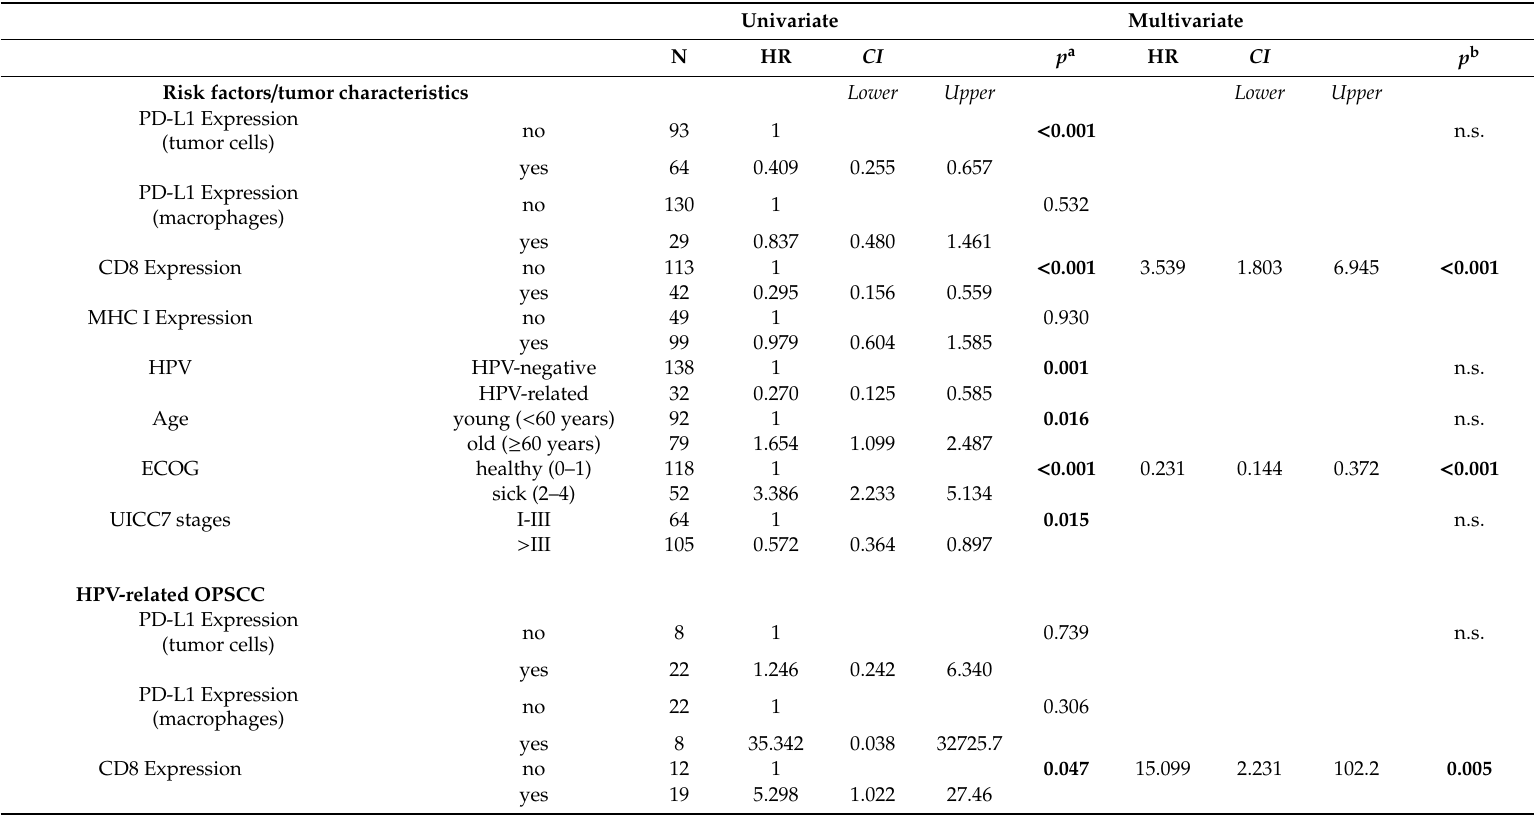
Table 3. Univariate and multivariate survival analysis according to risk factors and tumor characteristics ( n = 171). Univariate Multivariate N CI p b Risk factors / tumor characteristics